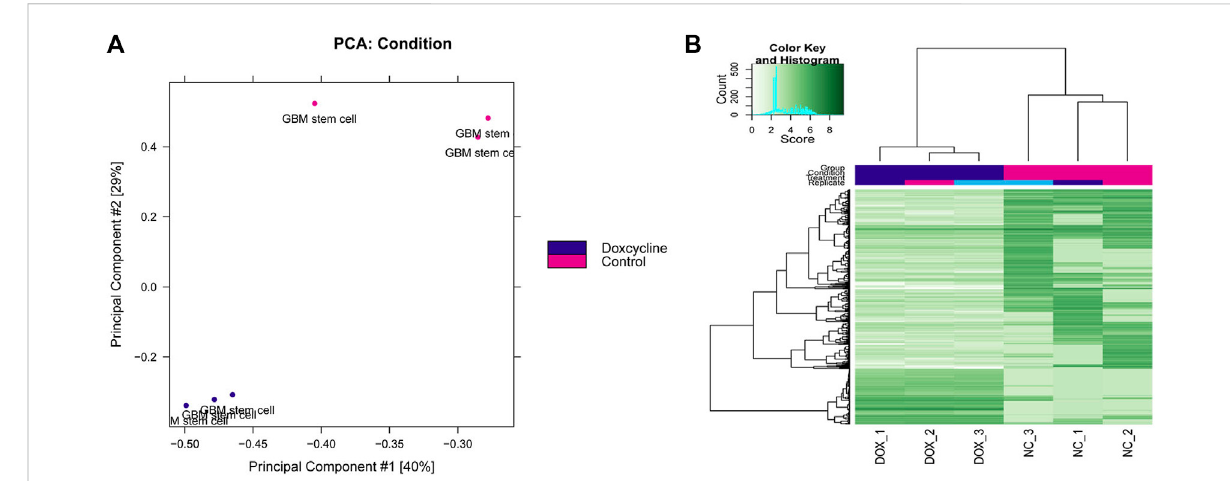
FIGURE 1 Principal component analysis (A) and two-dimensional hotspot clustering map of differential peaks (B) .